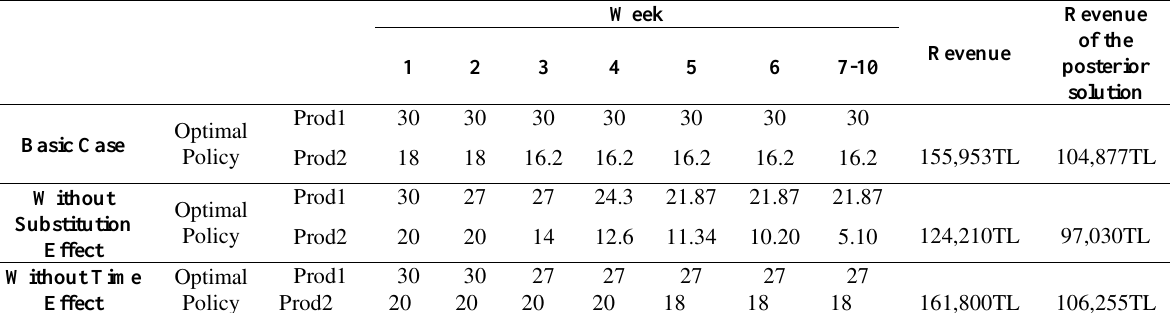
Table 4. Optimal policies obtained by Sarsa